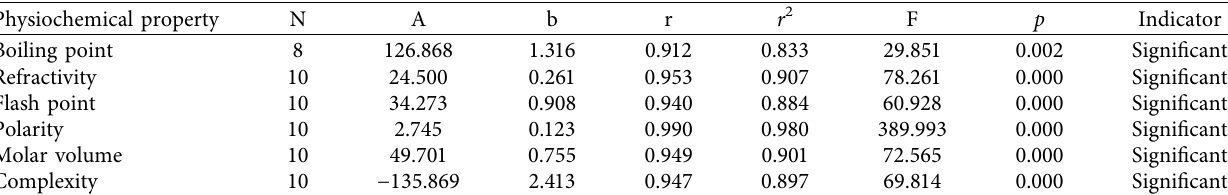
Table 7: Statistical parameters used in the QSPR model of